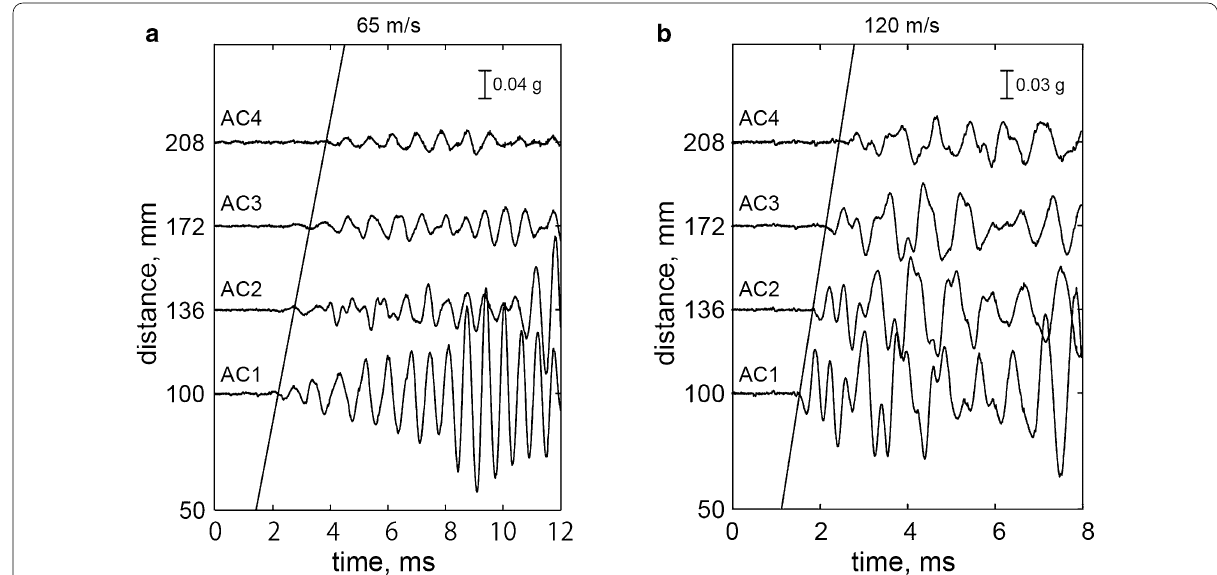
Fig. 7 The record sections of stacked waveforms at the initial measurements under a dry and b nearly saturated conditions. A fourth-order Butterworth band-pass filter from 0.1 to 100 kHz was applied to the waveforms. Oblique lines denote arrival